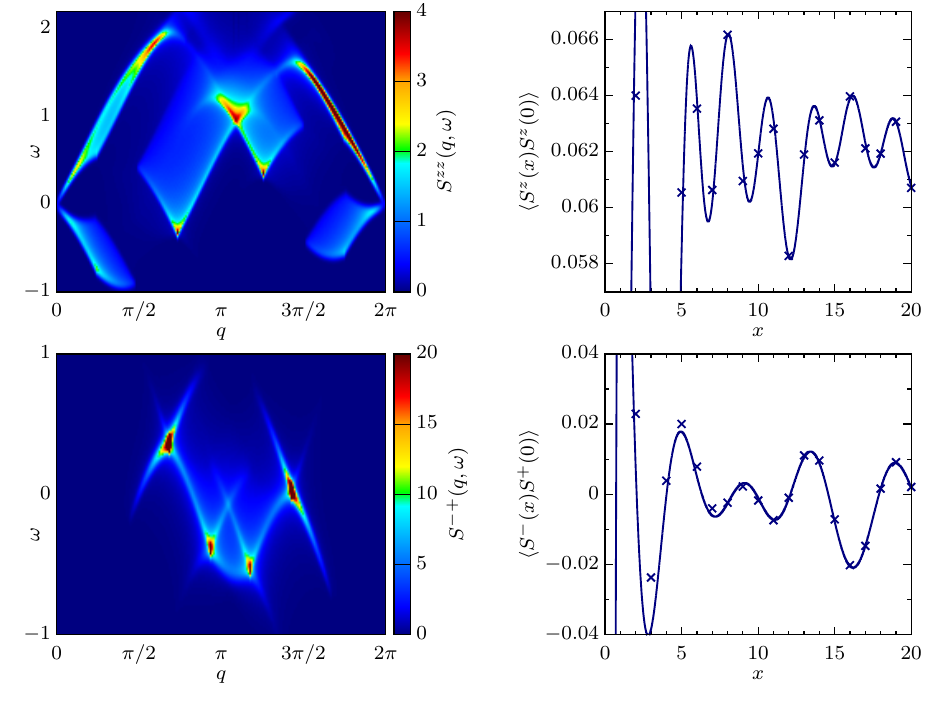
Figure 11: Dynamical (left column) and static (right column) correlations for a state with an asymmetric momentum shift for the two Fermi seas by s 50, ∆ = 1. The panels in the right column show the resemblance between the real space correlations obtained from ABACUS (points) and the multi-component Tomonaga-Luttinger model (lines). The saturation of the ABACUS data is given in Tab.